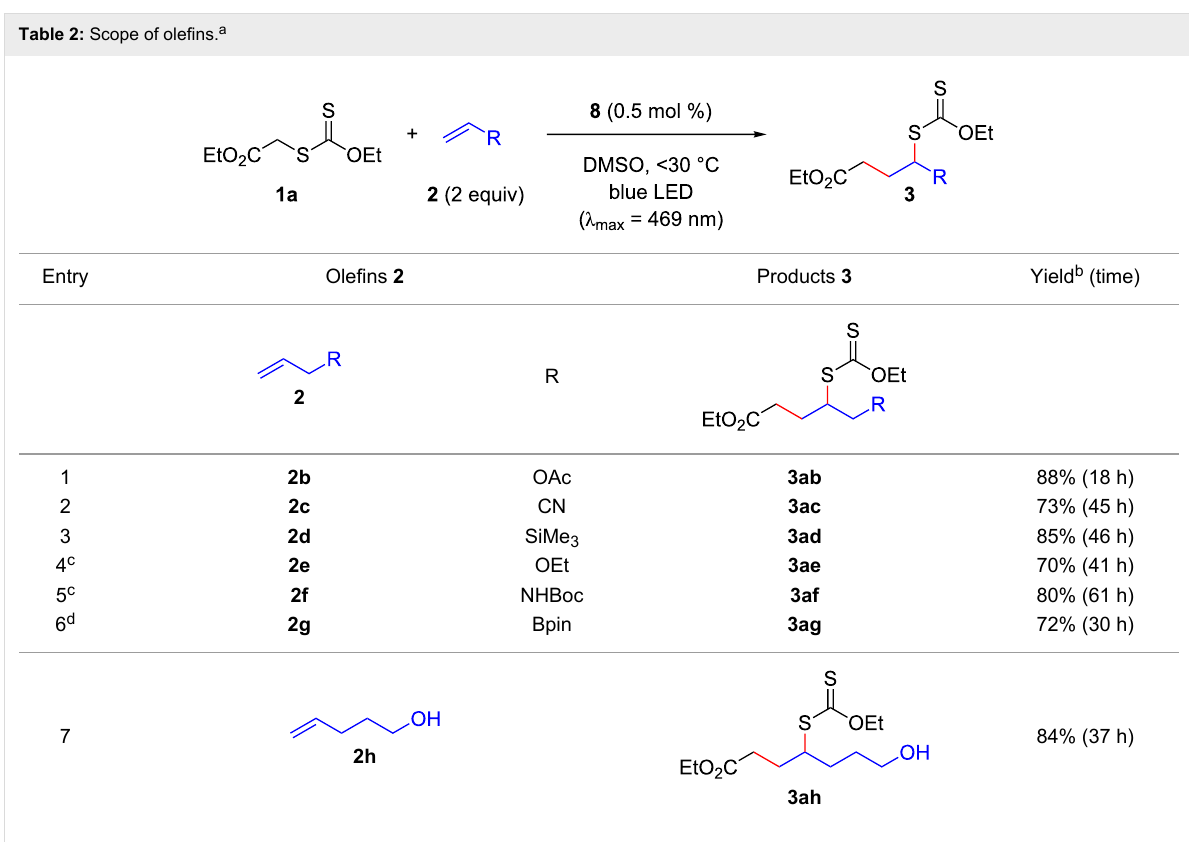
Table 2: Scope of olefins.